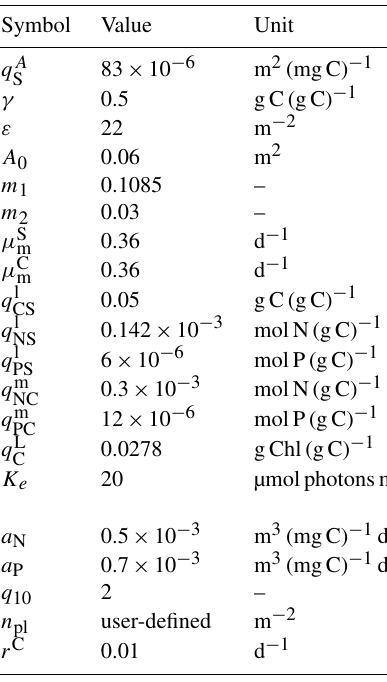
Table 2. Parameters of the macroalgae